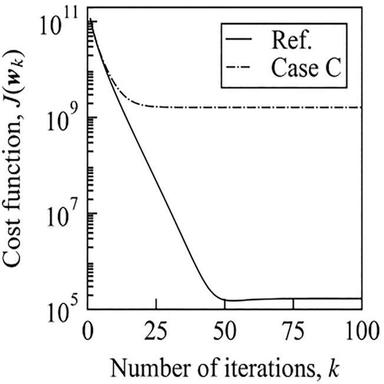
Evolutions of the cost function, J(w), at each iteration step using the observation data without noise (reference case) and the synthetic observation data including the noise with a standard deviation equal to 100Rt (Case C).